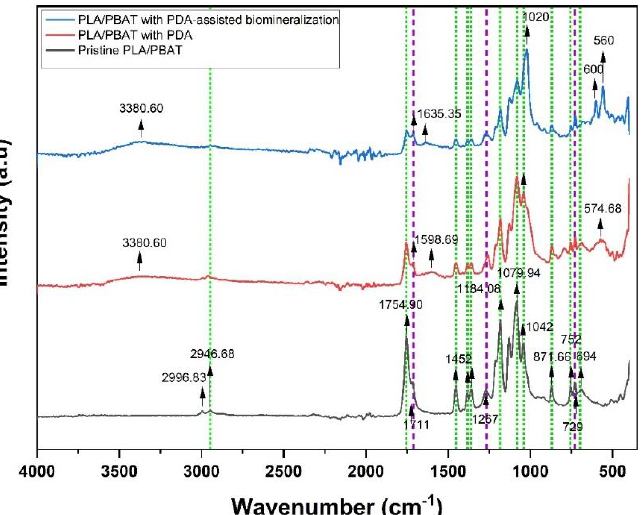
Figure 9. Fourier-transform IR (FTIR) spectra of pristine PLA/PBAT, PLA/PBAT with PDA, and PLA/PBAT with PDA-assisted biomineralization. The green and purple dashed lines indicate the characteristic bands of PLA and PBAT, respectively.